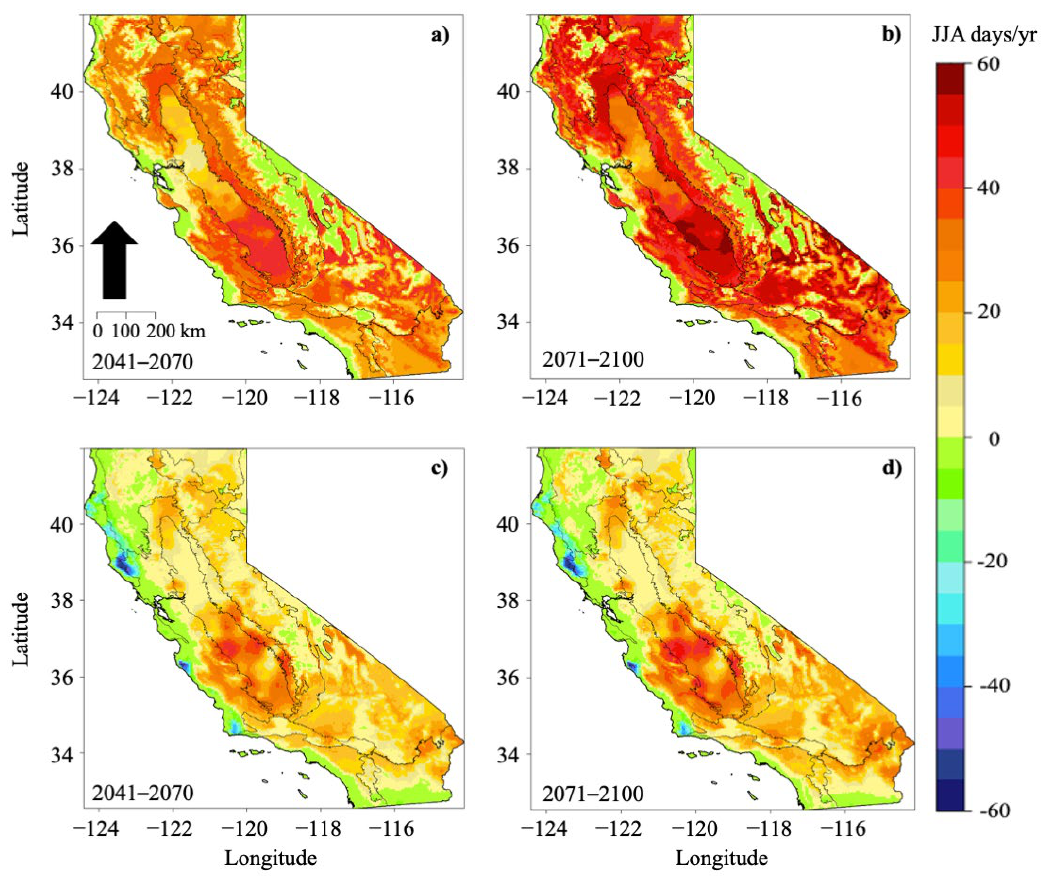
Figure 6. Average frequency (in days/yr) with which VPD and FWI exceed the ecoregion-specific daily average JJA 95th percentile in the mid-century ( left ) and late-century ( right ) relative to the historic period. Higher values indicate more JJA days each year that exceeded the 95th percentile. ( a , b ) Vapor pressure deficit ( c , d ) Fire Weather Index.